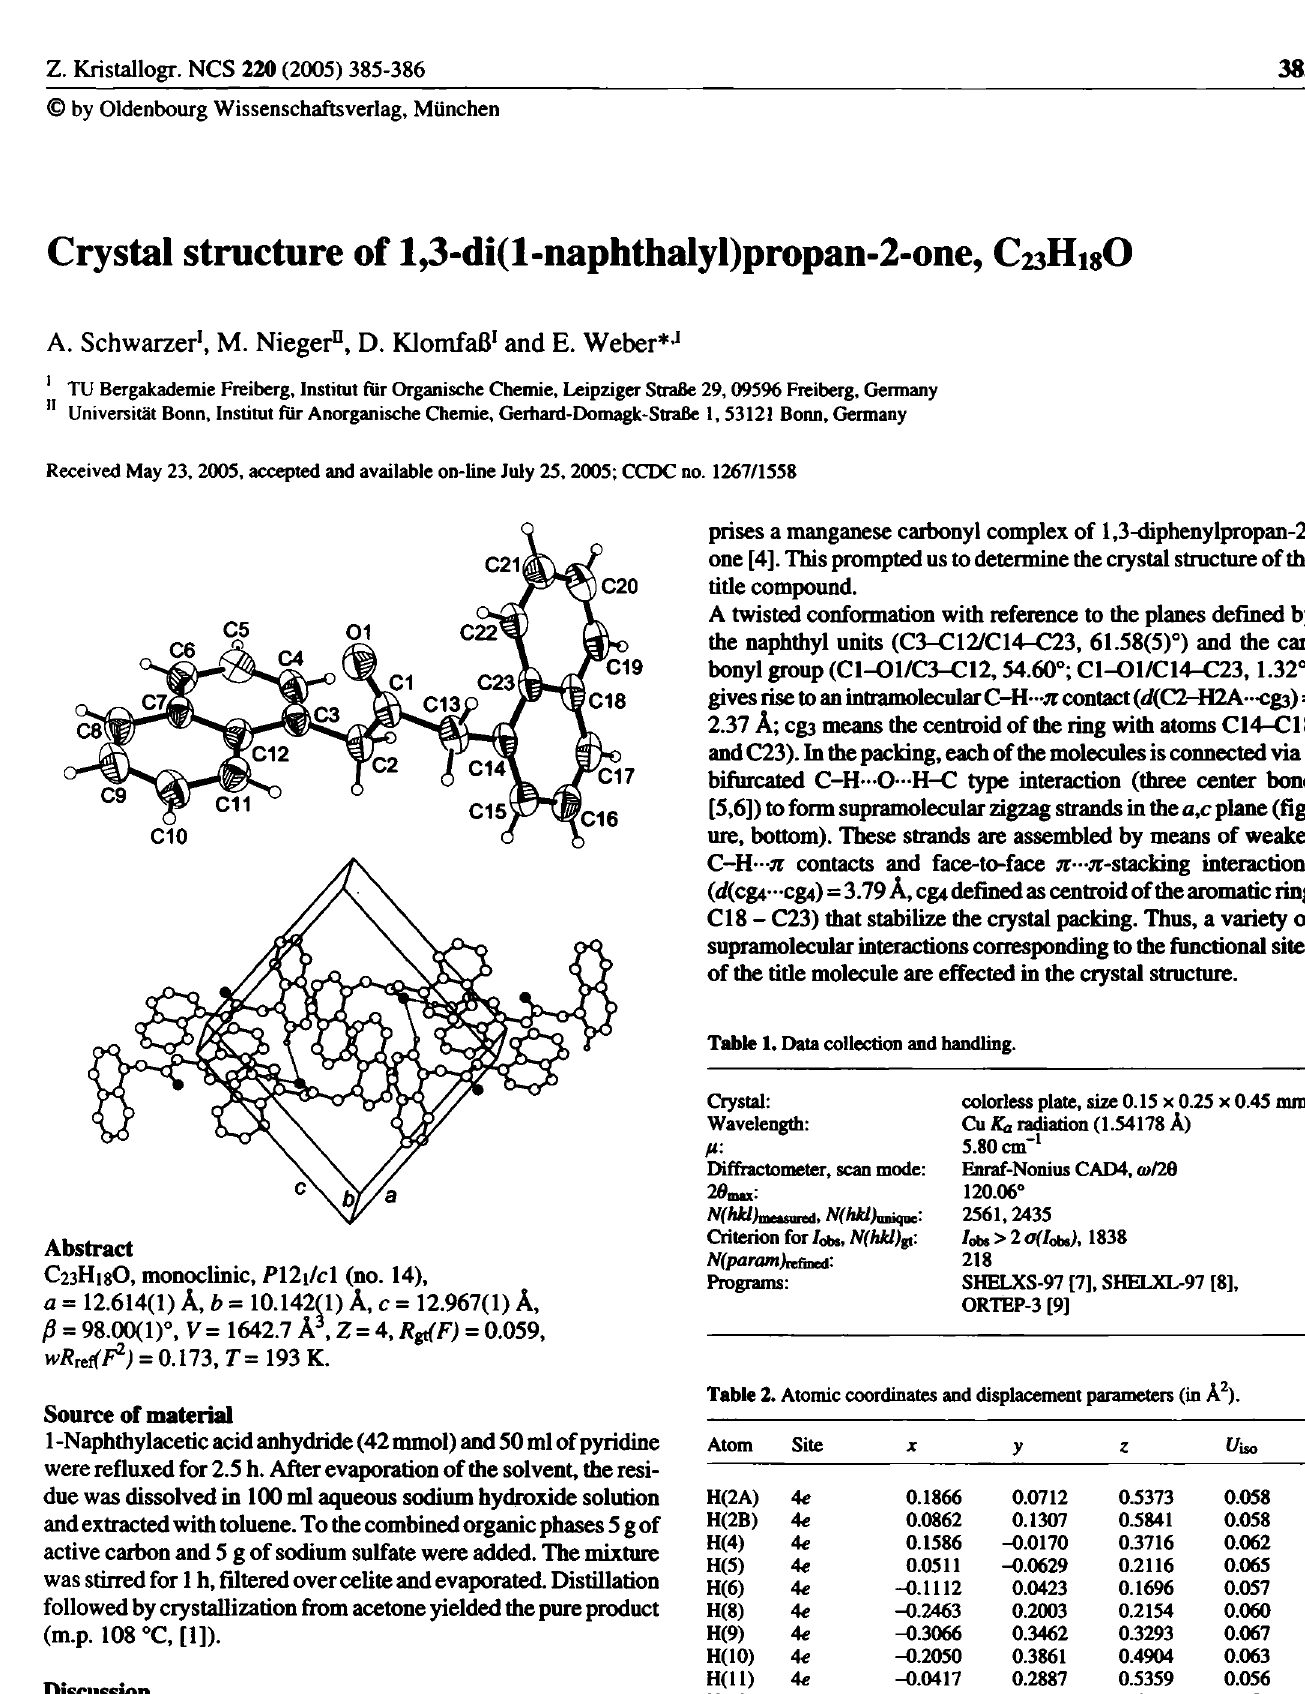
Table 2. Atomic coordinates and displacement parameters (in Ä 2